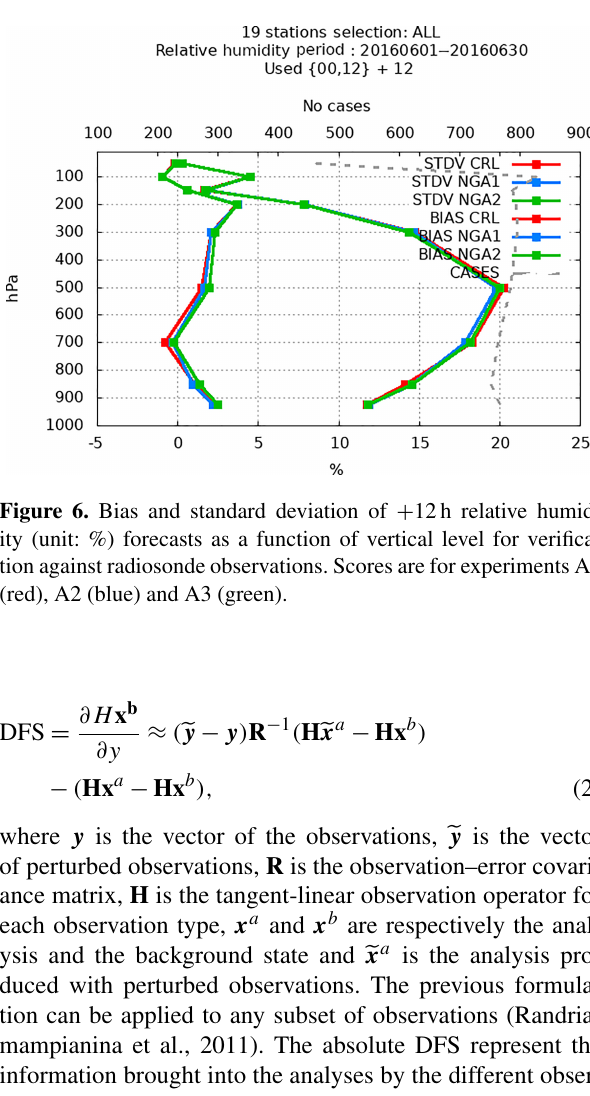
Figure 5. Degree of freedom of signal subdivided into various ob- servation types for the four experiments A1, A2, C2 and D2. Results were based on data from eight different data assimilation cycles.